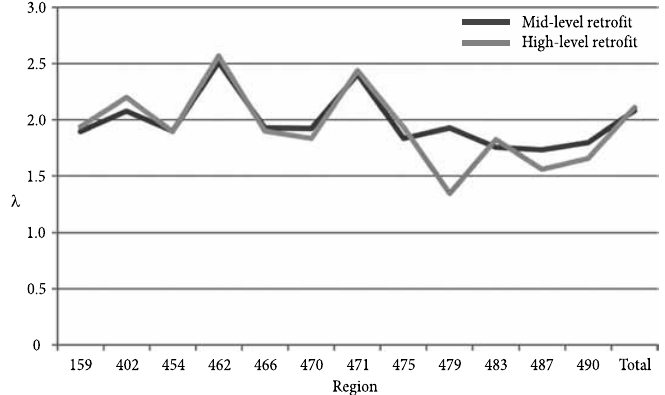
Fig. 4. Estimation of framework benefit factor ( h = 50%, i = 10)